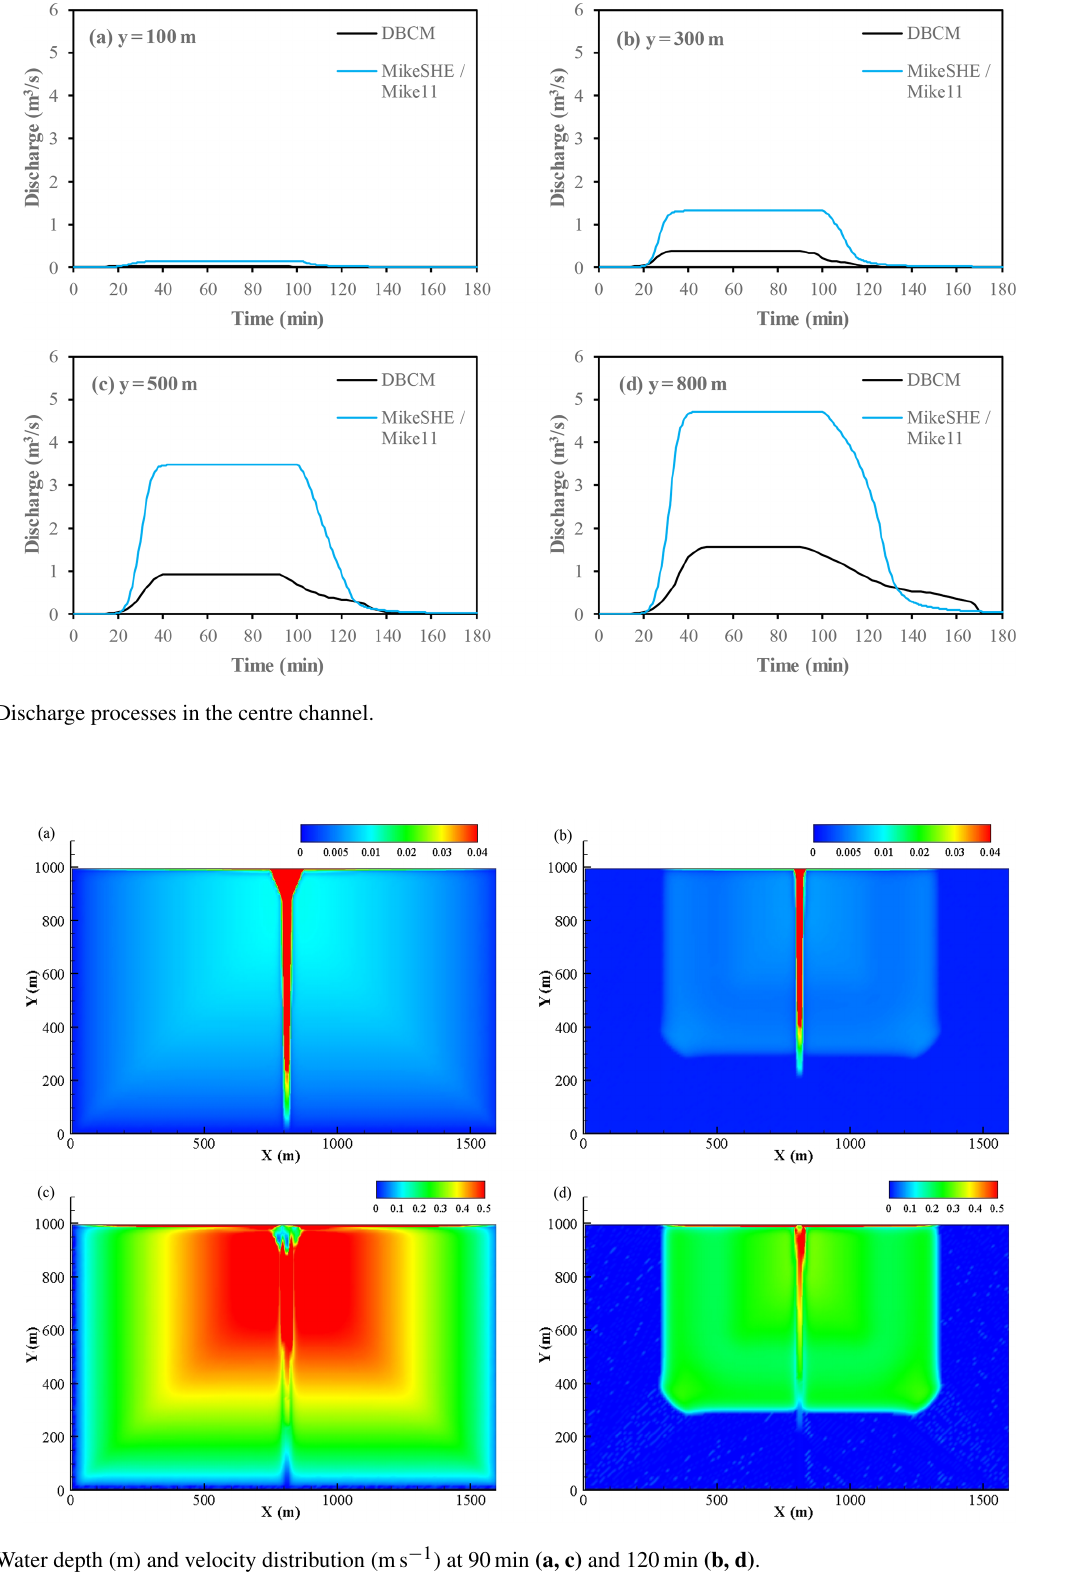
Nat. Hazards Earth Syst. Sci., 21, 497–515,